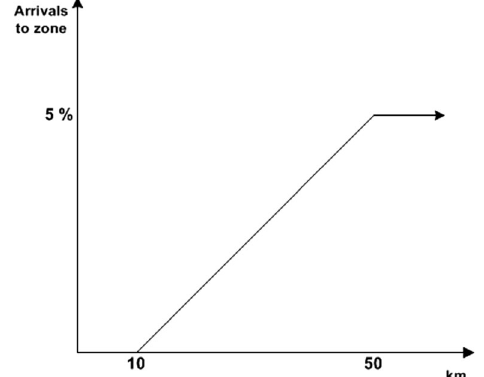
Fig. 2 Estimation of electric vehicles charging needs in 2020 based on the assumptions made in this approach